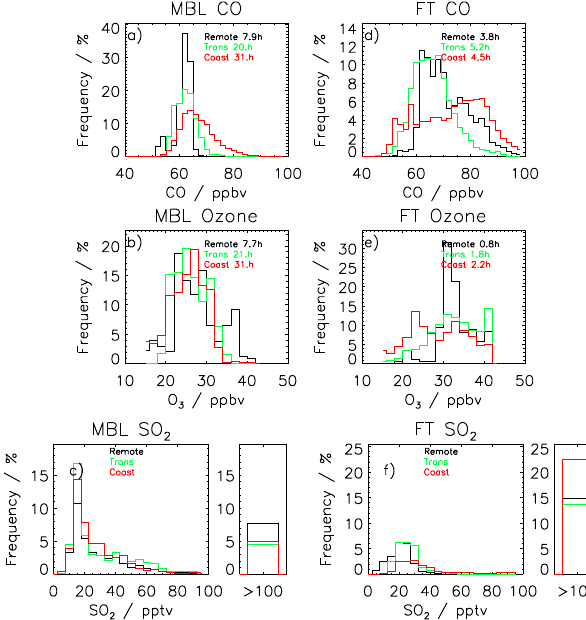
Fig. 6. All-aircraft carbon monoxide (top panels), ozone (centre panels) and sulphur dioxide (lower panels) concentration probability density functions gridded into longitudinal zones (colour-coded as indicated) along 20 ◦ S, in the MBL (left panels) and the FT (right panels). Total sampling time in hours is plotted in each panel for each zone. Note that sampling time for sulphur dioxide is equal to that stated for ozone. See text for further